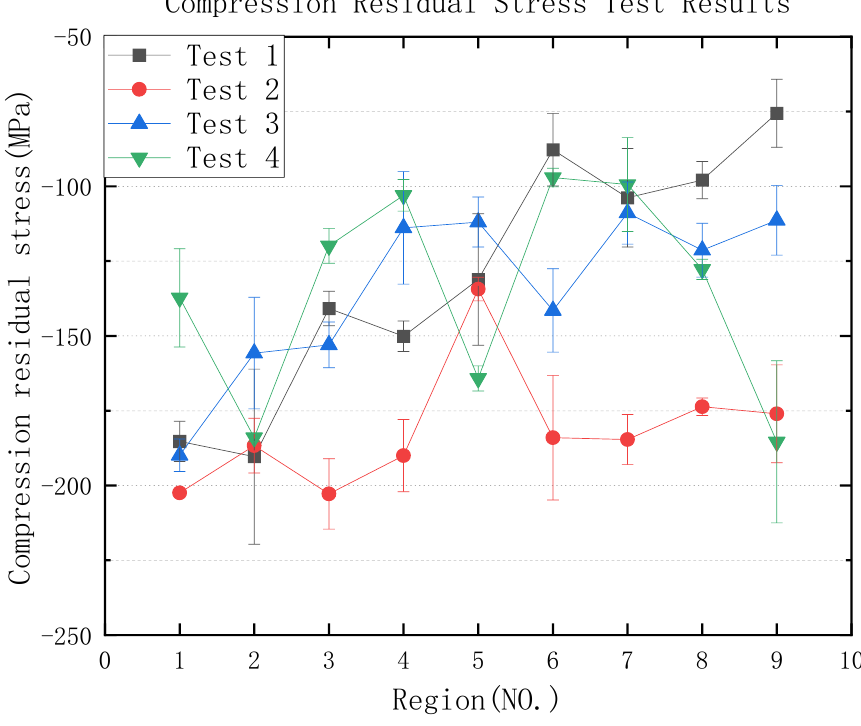
Figure 4. Compression residual stress test results.